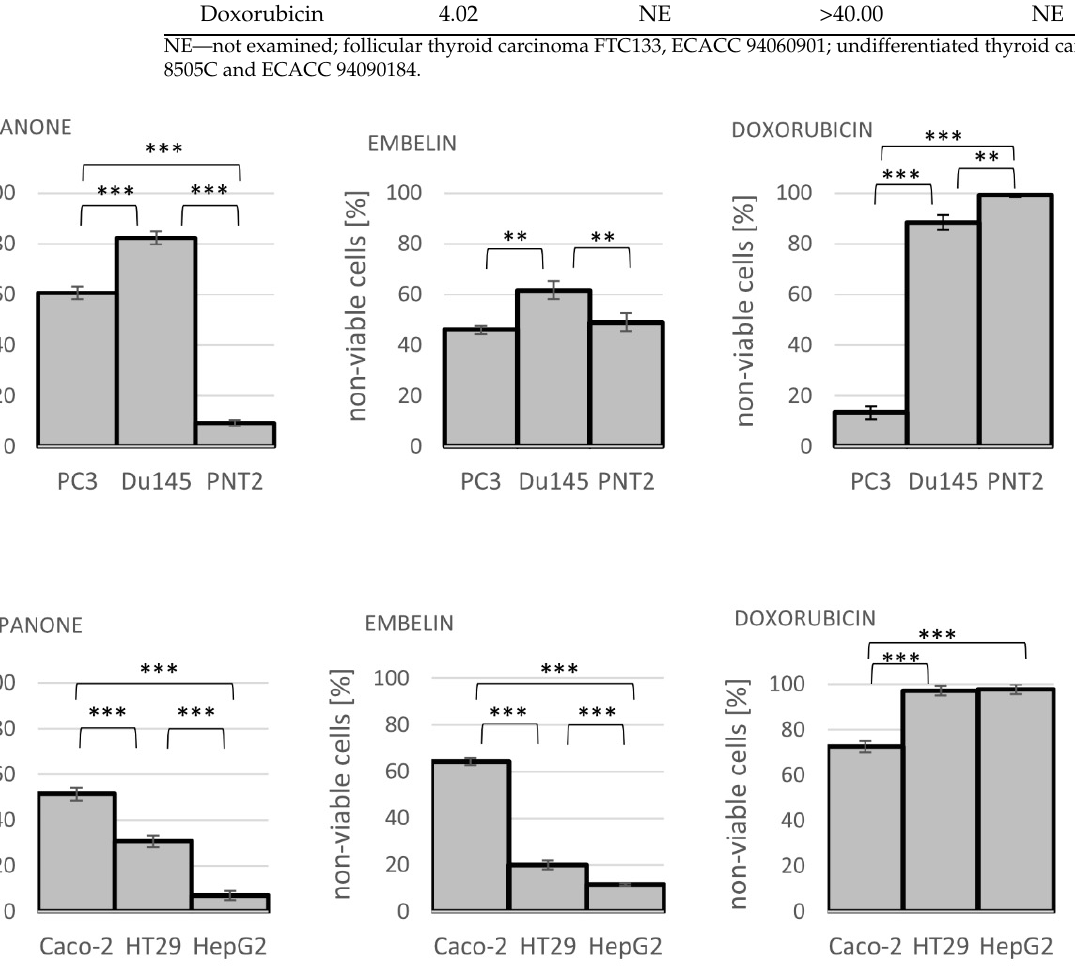
Figure 3. Cytotoxic activity of rapanone, embelin, and doxorubicin at 10 µ g/mL towards cell lines of prostate and gastrointestinal panels (see Material and Methods section for cell line descriptions); ** p < 0.01, *** p < 0.001.